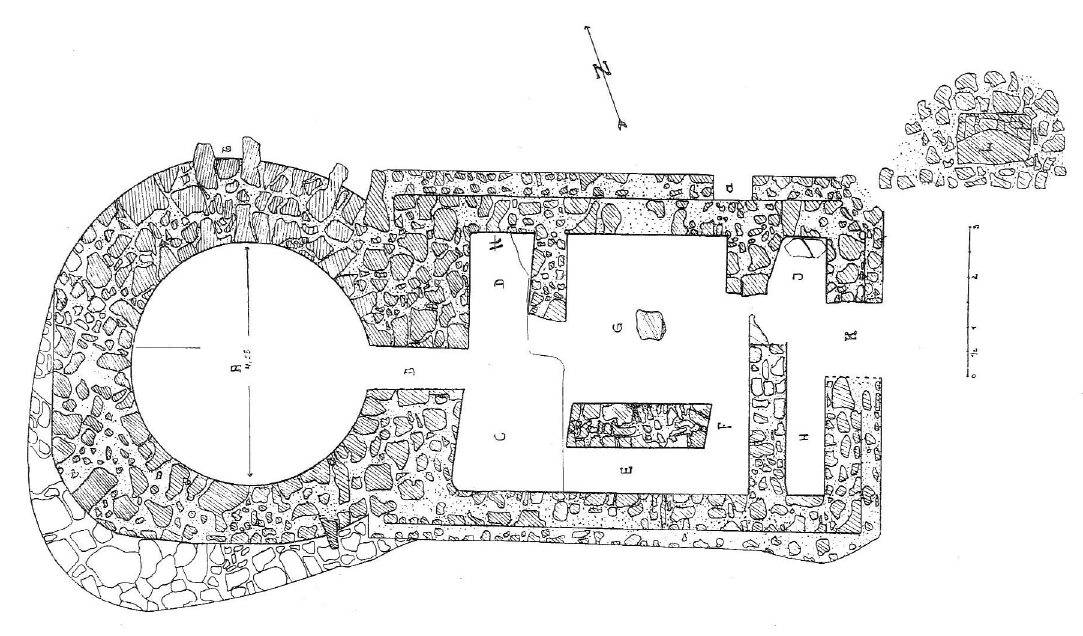
Figure 3. Plan of Tholos A at Apesokari (Schörgendorfer, 1951, pl. 16; reproduced by